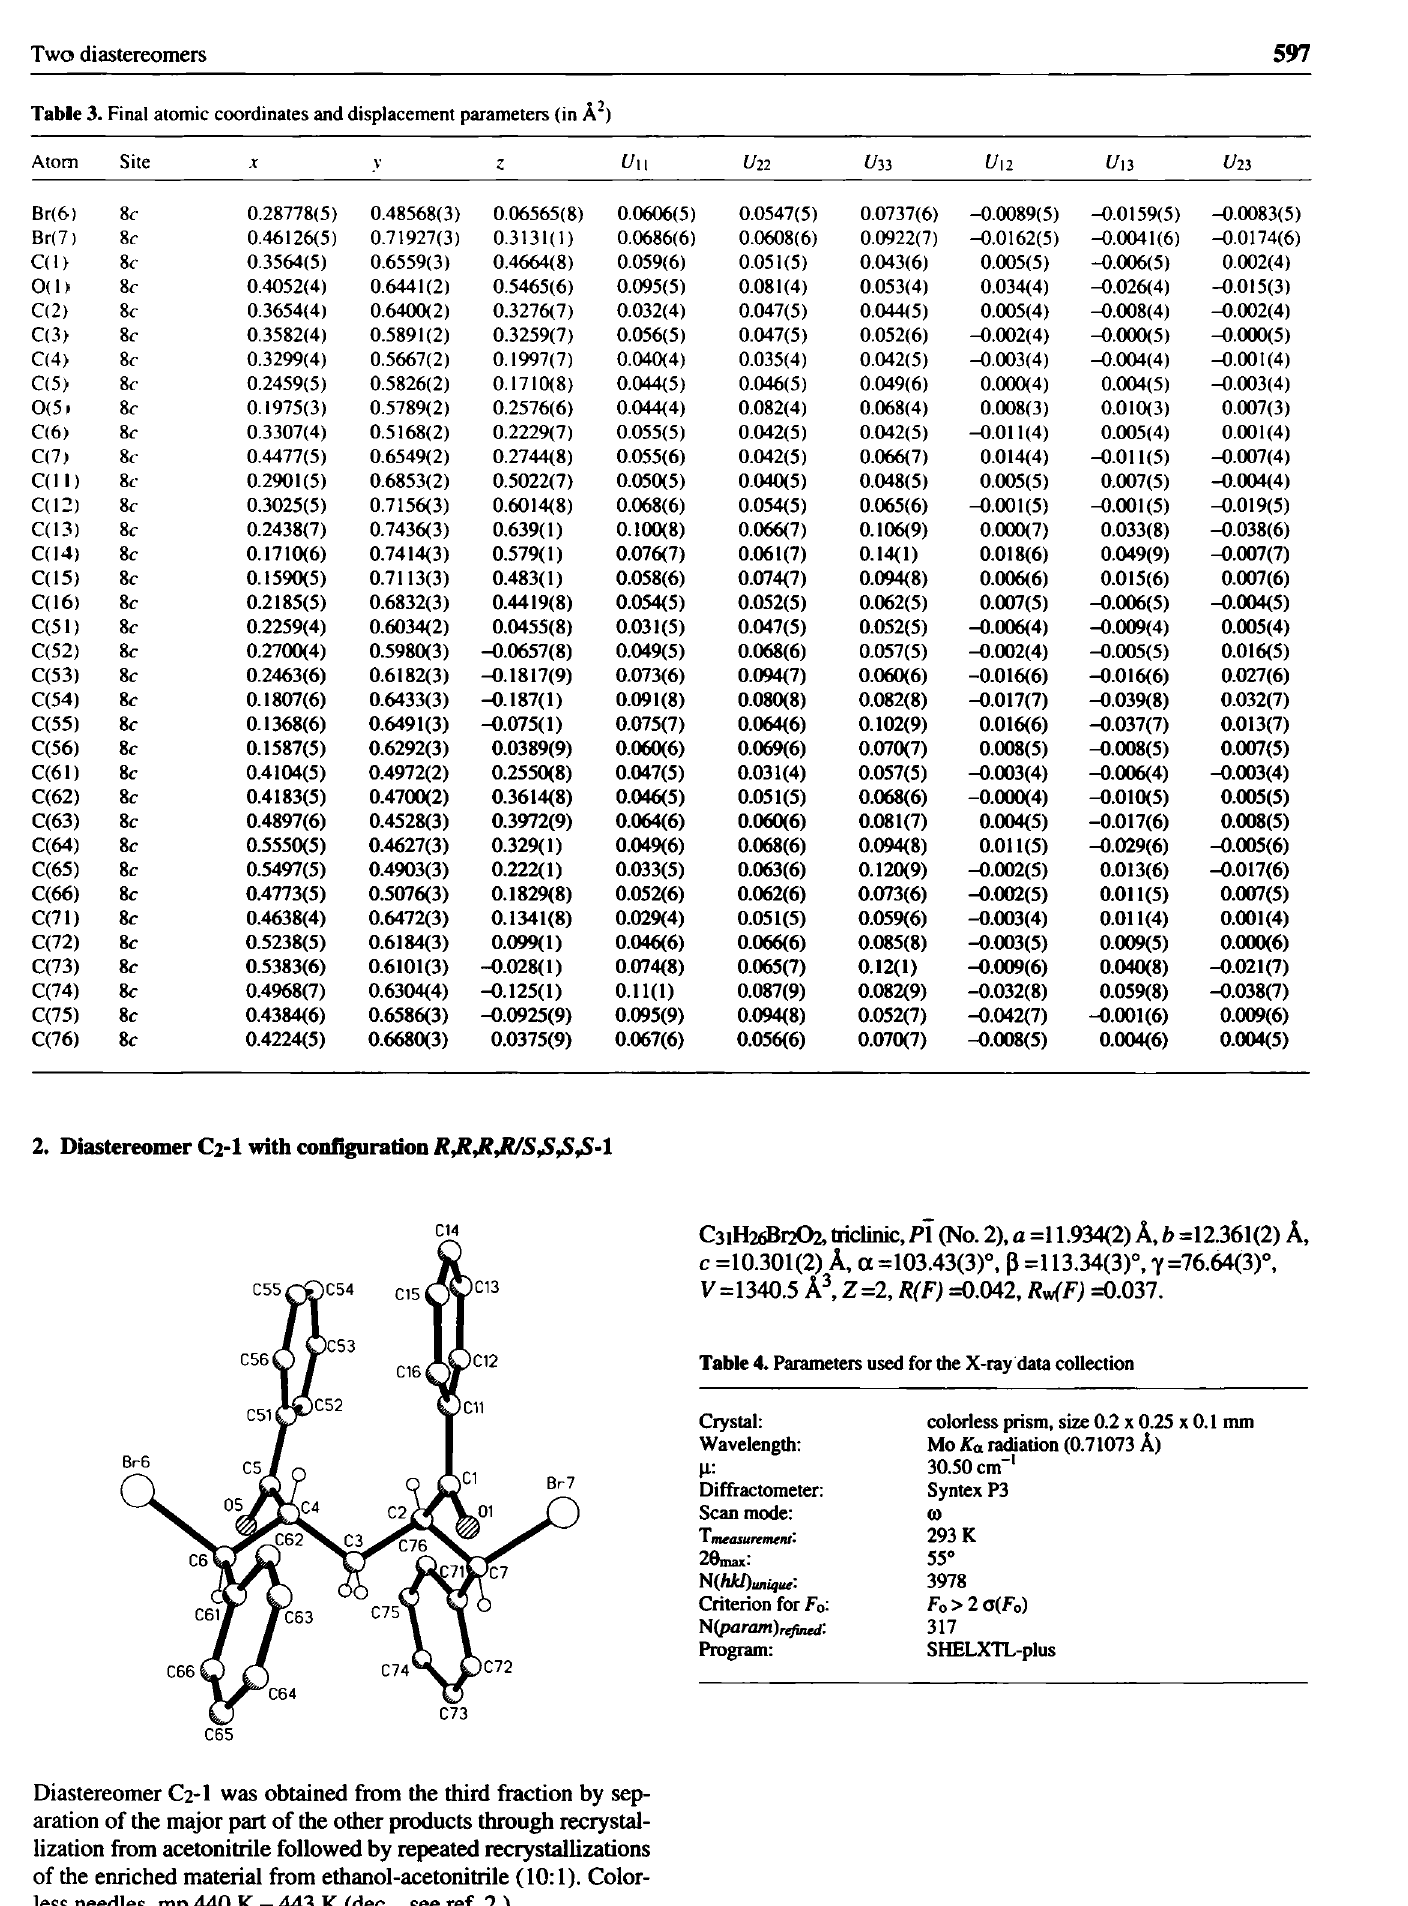
Table 4. Parameters used for the X-ray data collection